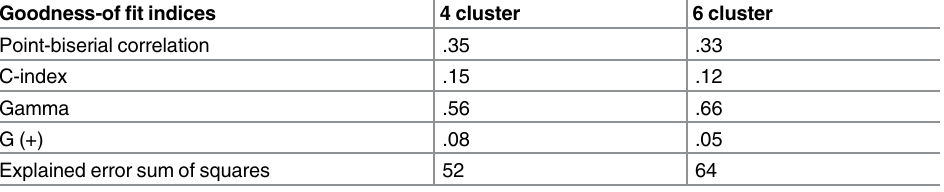
Table 3. Fit indices of the four- and six-cluster solution identified through K-means cluster